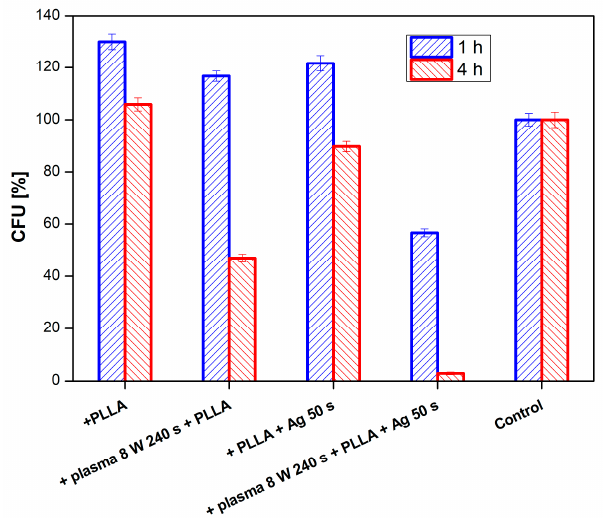
Figure 11. Antimicrobial activity of plasma-activated PTFE + poly-L-lactic acid (PLLA) further deposited with Ag against bacterial strains E. coli after 1 and 4 h of incubation. Plasma treatment was done with 8 W for 240 s, Ag deposition for 50 s.